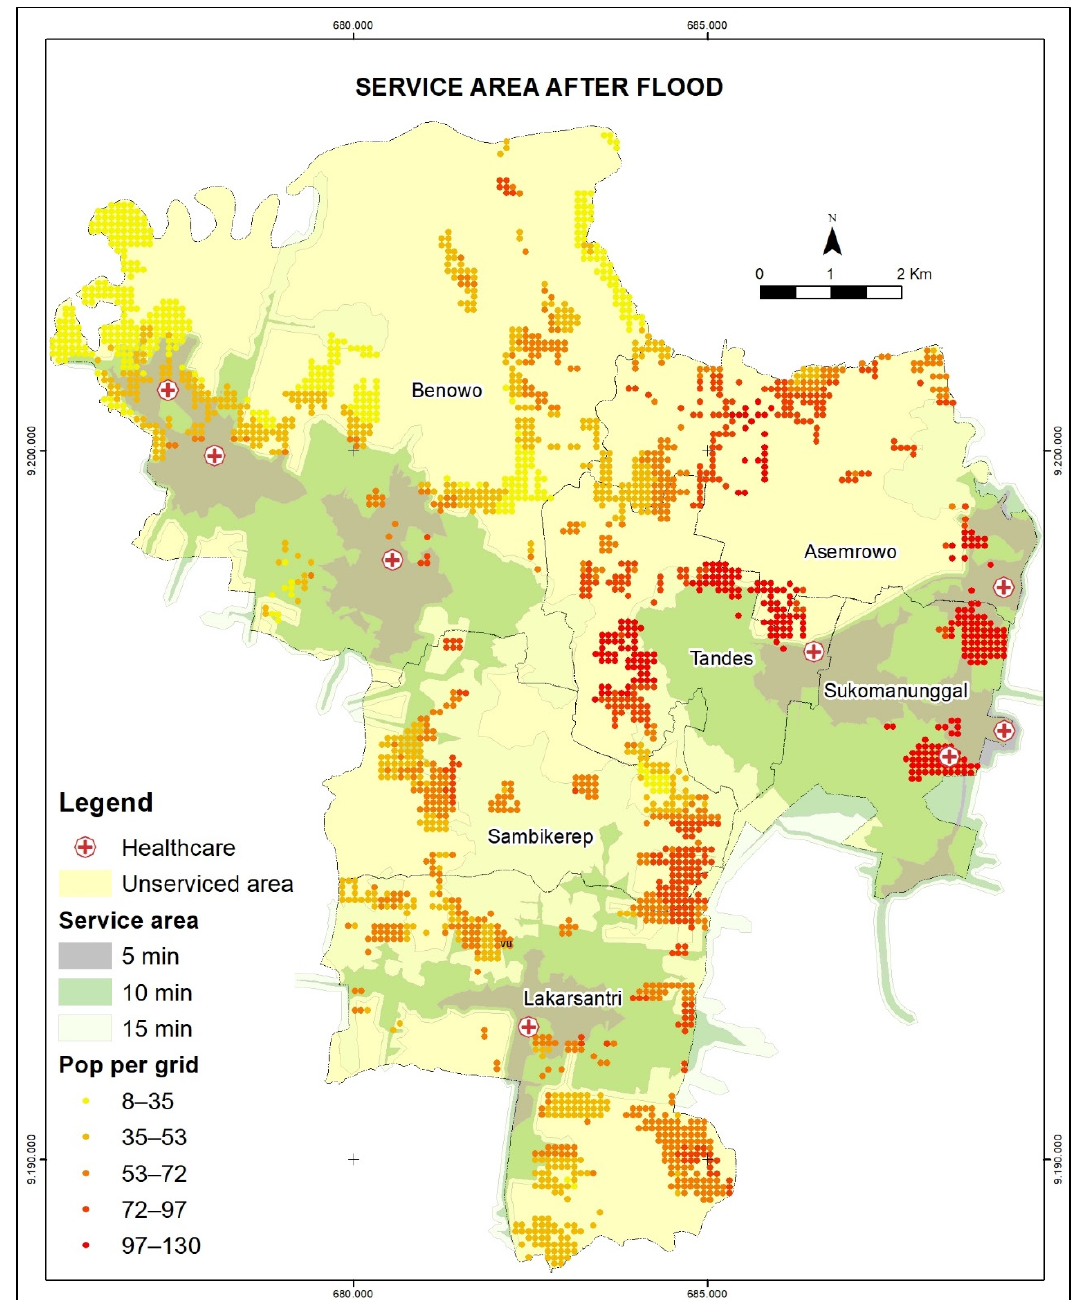
Figure 10. Healthcare service area after flood.